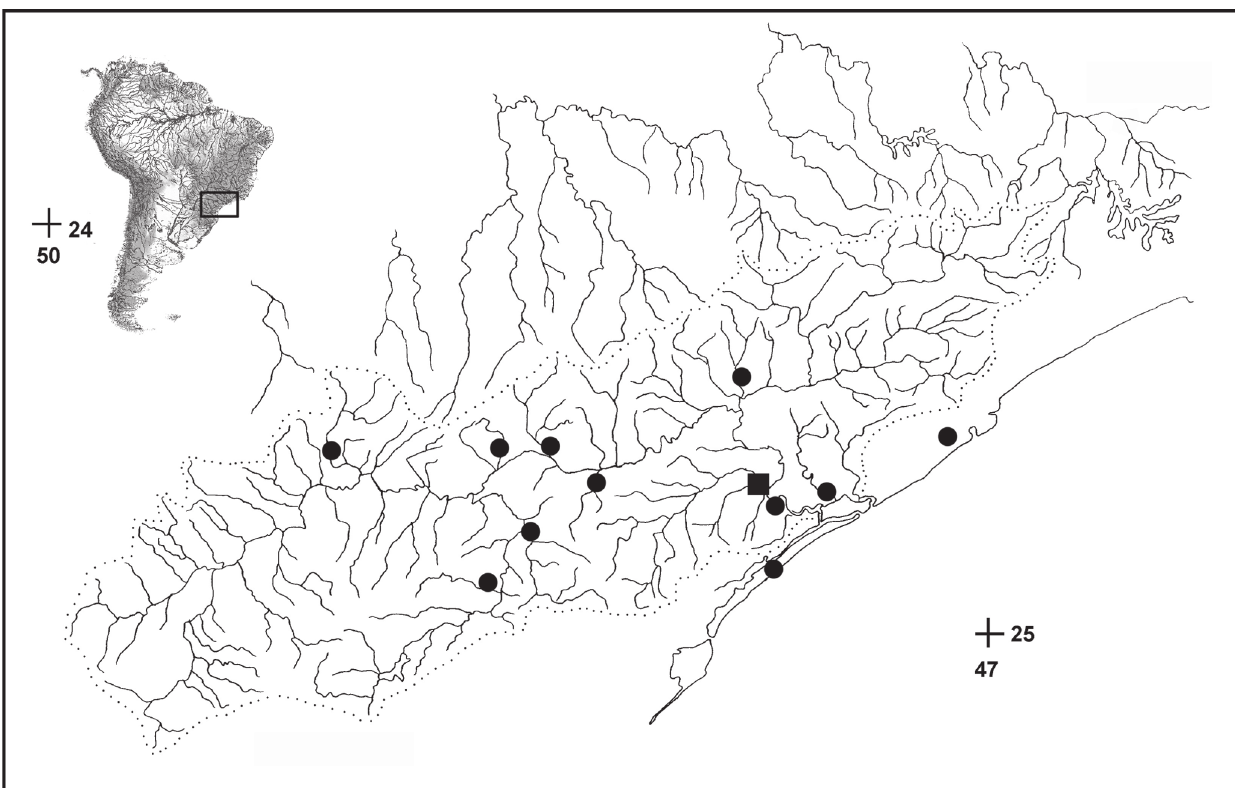
Fig. 3. Drainage map of the rio Ribeira de Iguape basin, showing geographic distribution of Pimelodus multicratifer . Type locality represented by square. Some symbols represent more than one lot of